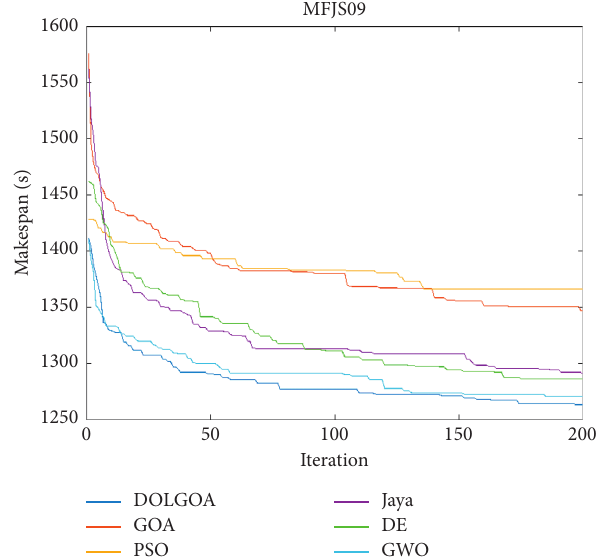
Figure 6: Convergence results of MFJS09 for all the compared algorithms.